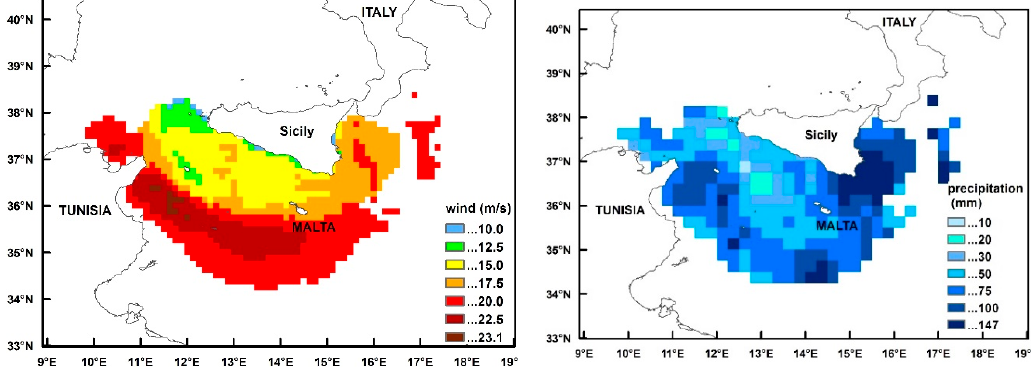
the week after the event (10–17 December 2008) and the December climatological mean values.